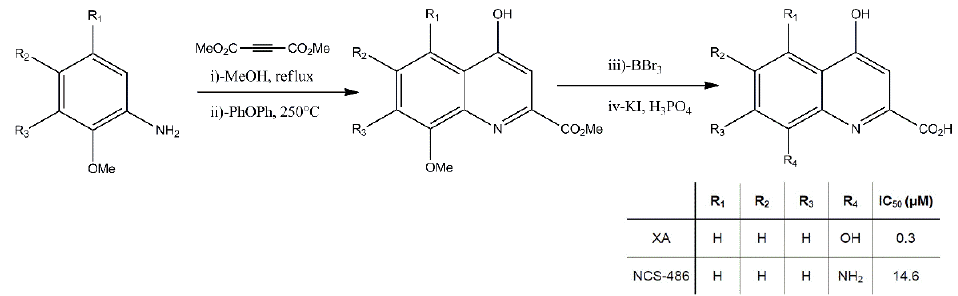
Figure 7. The synthesis of NCS-486 was carried out in a two-step reaction starting from readily available methyl-8-nitro-4-oxo 1,4 dihydroquinoline 2-carboxylate as described in [30]. Reduction of the nitro group and hydrolysis of the methyl ester were performed according to the previous description in Taleb et al. [26].